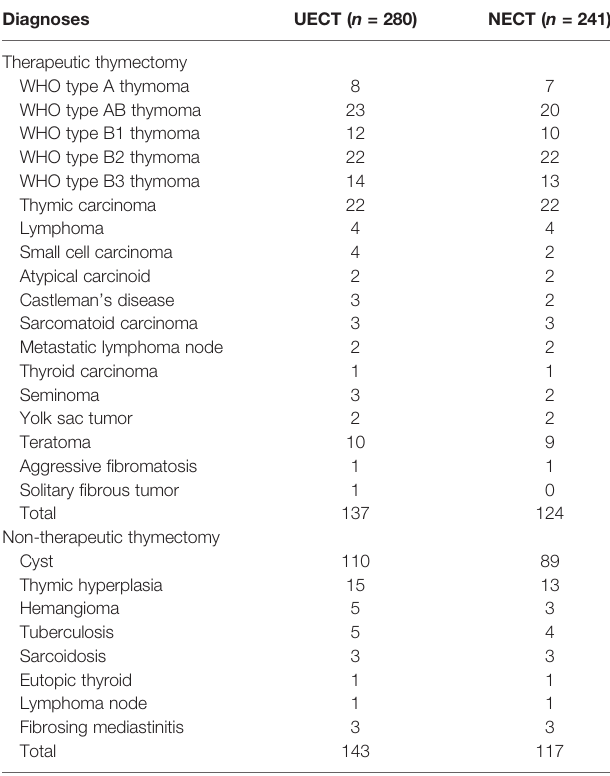
TABLE 1 | Pathology characteristics of patients in UECT and